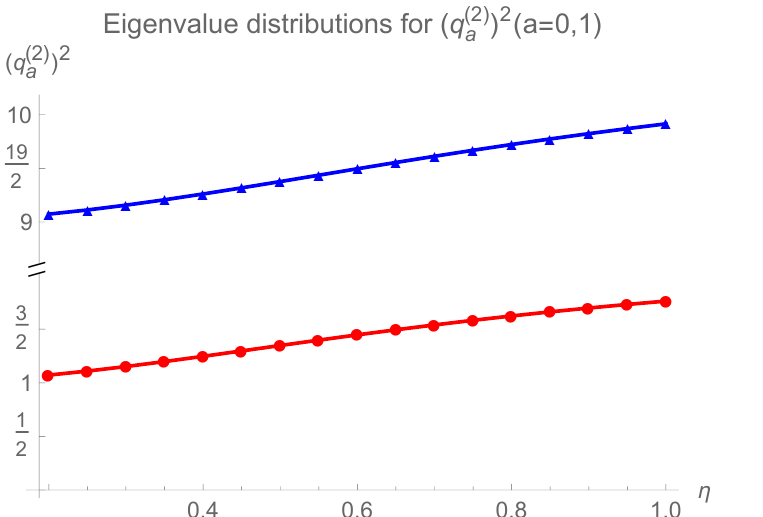
. The blue curve corresponds to 2 ) 2 0